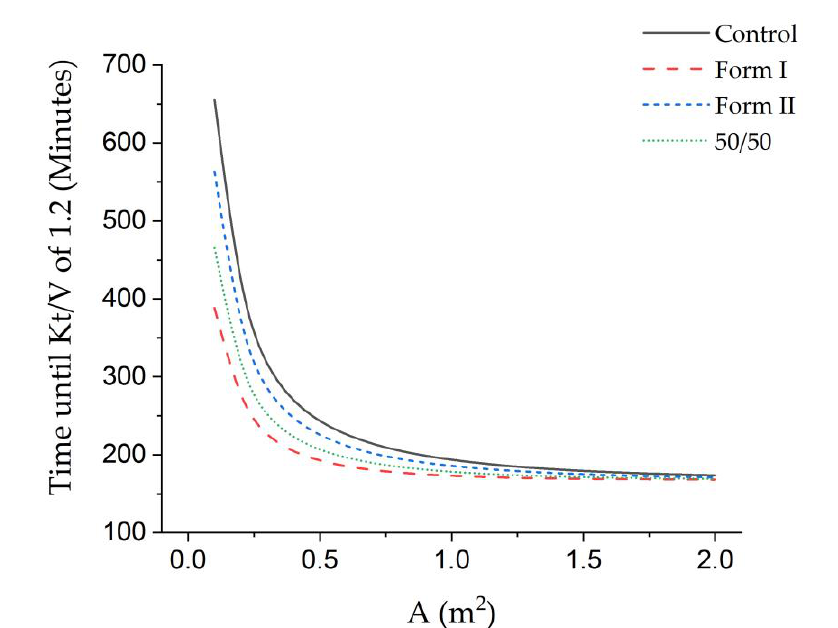
Figure 5. Dimensionless analysis of the time of clinical operation completion (Kt/V=1.2) as observed against membrane surface area, A (m 2 ), for the control, Form I, 50/50, and Form II samples show membrane performance at different active membrane areas under the same conditions, i.e., a 300mL/min feed flow rate and 500 mL/min dialysate flow rate using the same assumptions utilized in Table 3.